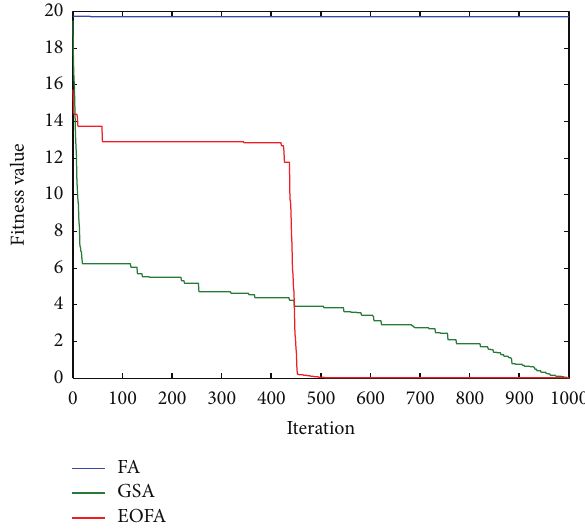
Figure 3: Comparison of performance of FA, GSA, and EOFA for benchmark function F1 with dimension size 30.